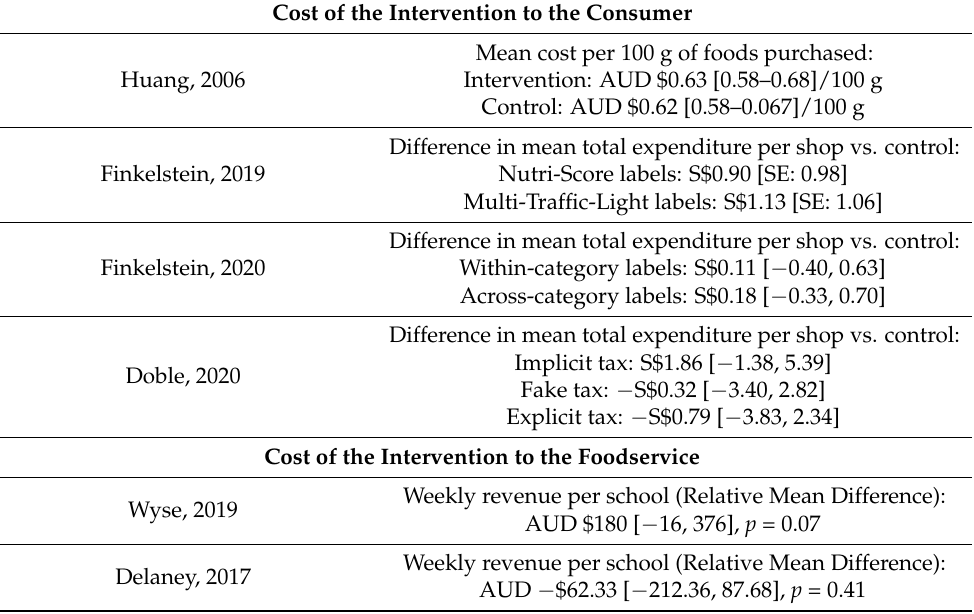
Table 2. Summary of intervention